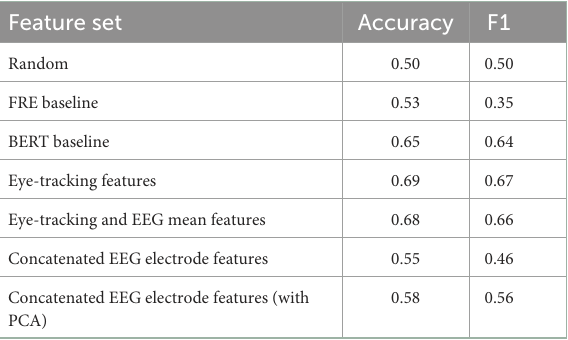
TABLE 7 The mean accuracy and F1-score over all subjects for each feature-set in the benchmark